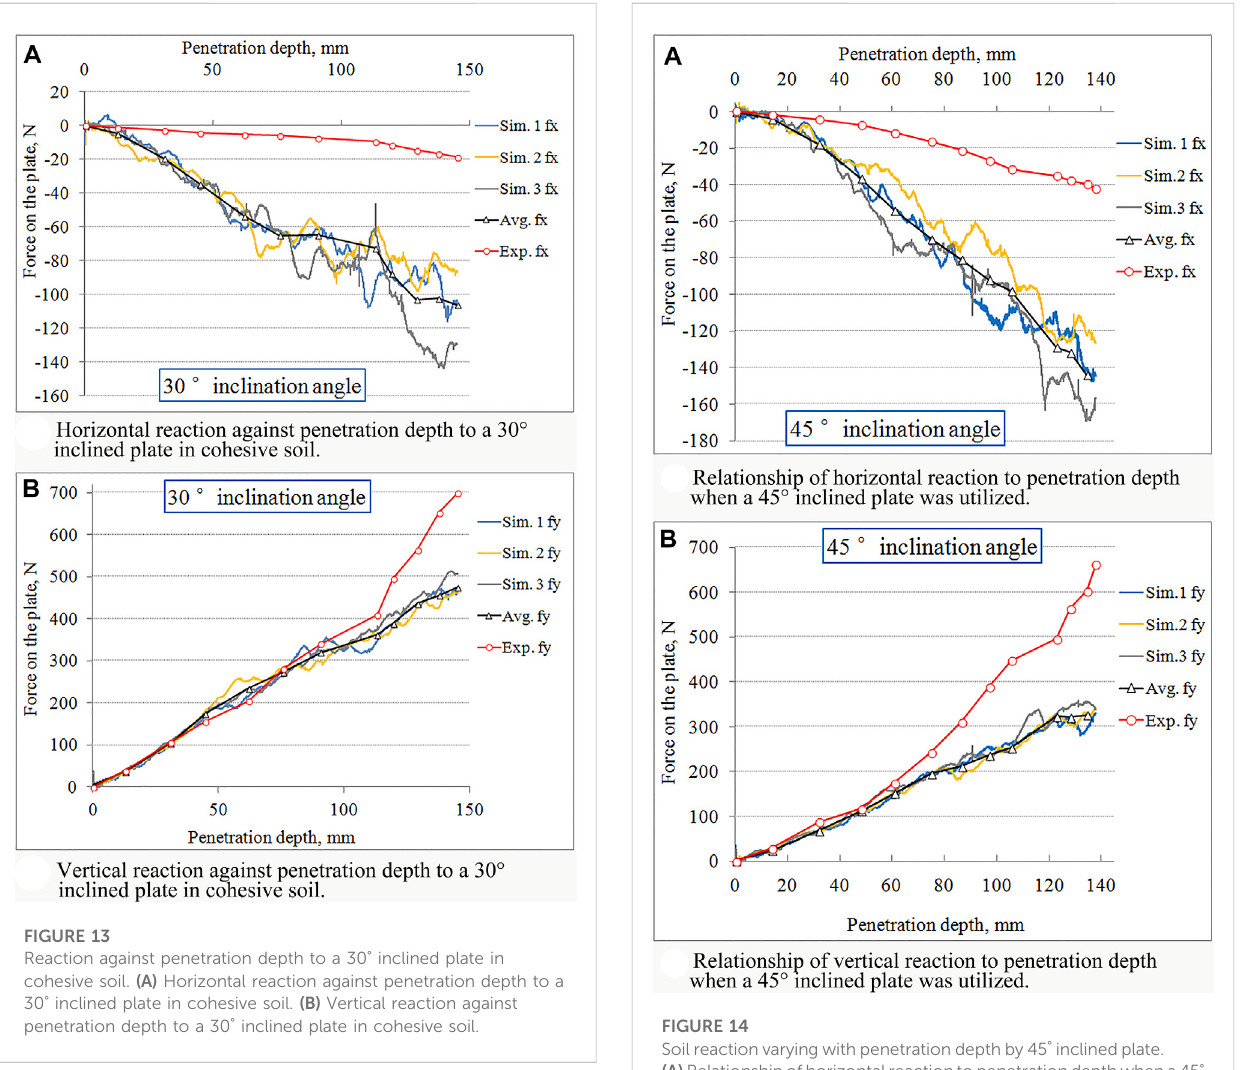
Soil reaction varying with penetration depth by 45 ° inclinedplate. (A) Relationshipofhorizontalreactiontopenetrationdepthwhena45 ° inclined plate was utilized. (B) Relationship of vertical reaction to penetration depth when a 45 ° inclined plate was